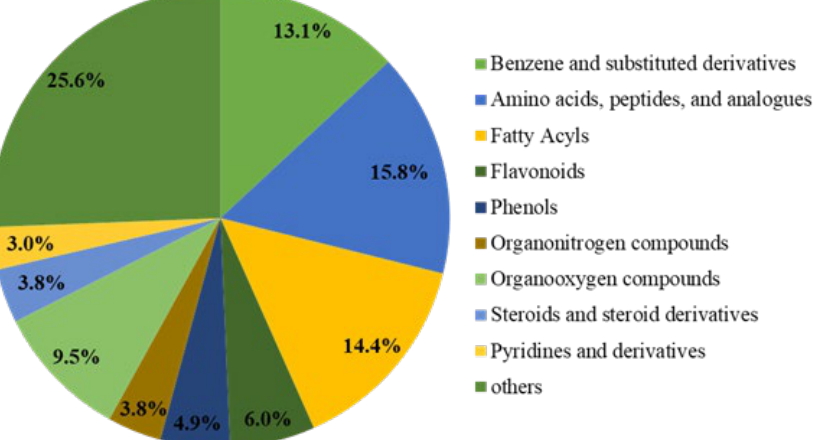
Figure 1. Pie chart depicting the biochemical categories of the differential metabolites.